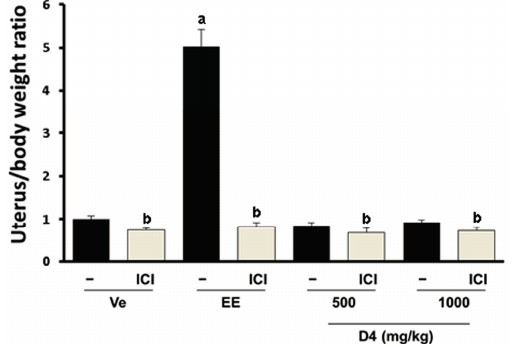
Figure 4. Uterus/body weight ratio measured by the UT assay in immature female SD